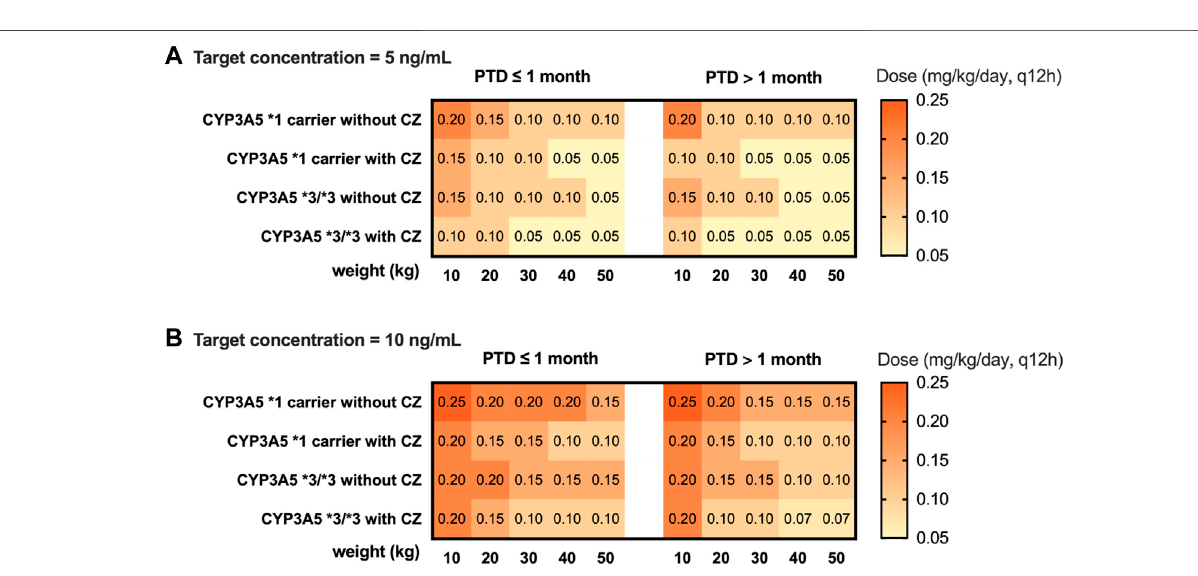
Frontiers in Pharmacology |